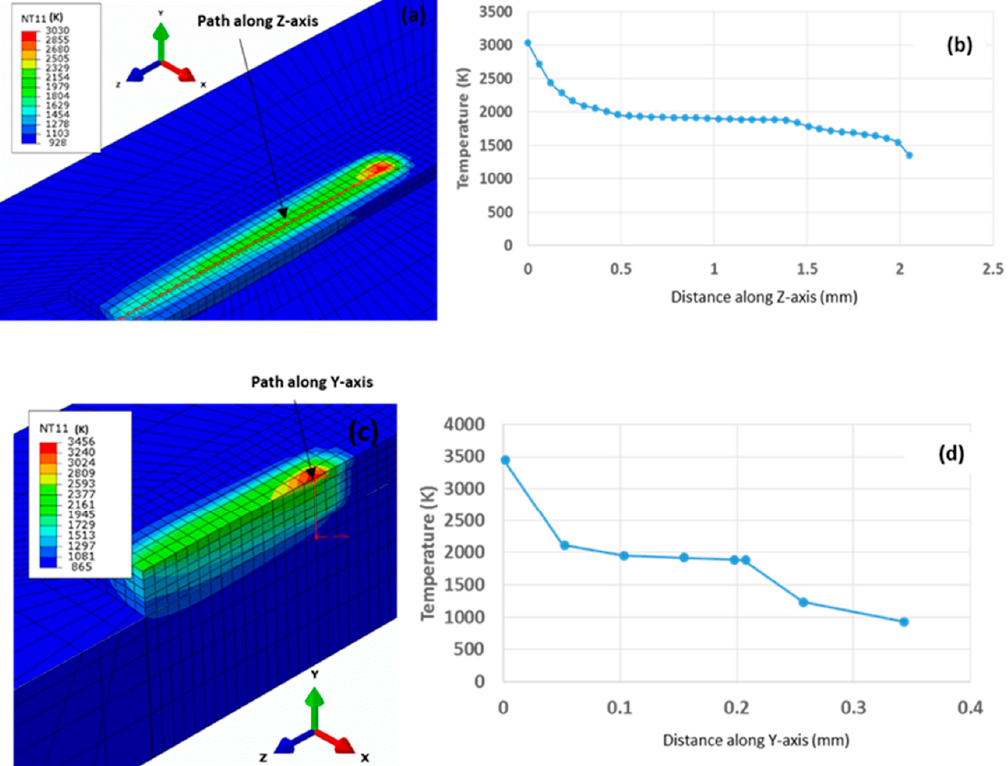
Figure 11. ( a ) Nodal path along the Z-axis ( b ) The plot for the temperature variation along the Z-axis nodal path, ( c ) nodal path along Y-axis, ( d ) the plot of the temperature variation along the Y-axis nodal path.